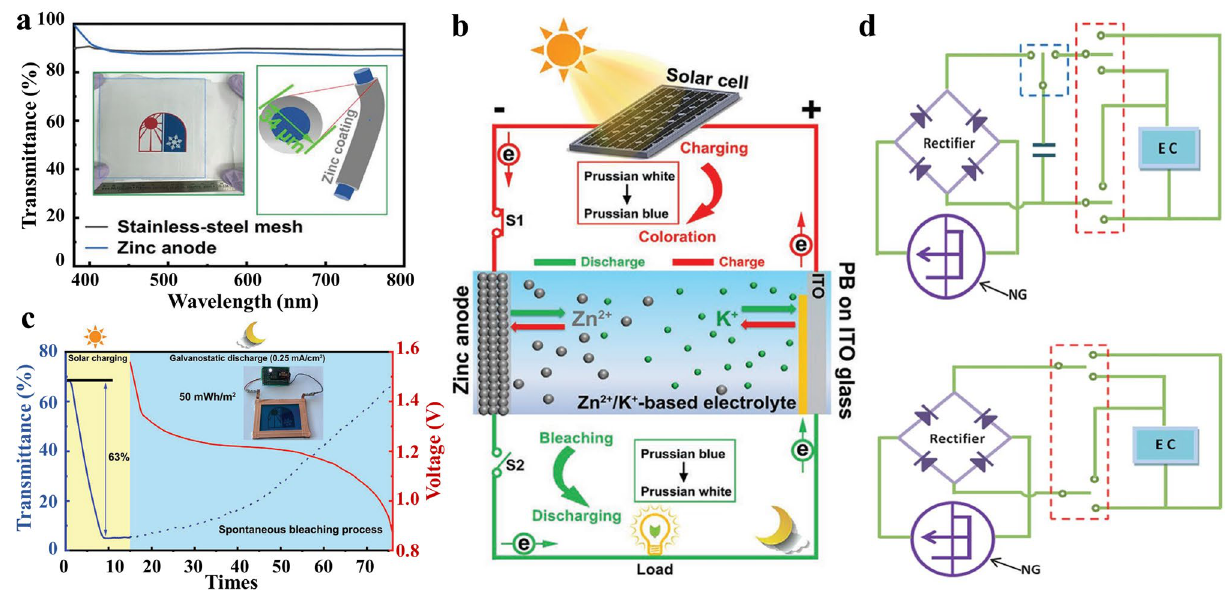
Fig. 12 Advances in integrated MERABs system. a Optical spectra of the core–shell-structured transparent Zn-mesh. b Schematic of the con- figuration of PV-MERAB and its work mechanism. c Optical and galvanostatic curves of the PV-MERAB [35]. Copyright 2020, Wiley–VCH. d Nanogenerator-charged power source and real-time power supply. Reproduced with permission [133]. Copyright 2012, Royal Society of Chem-